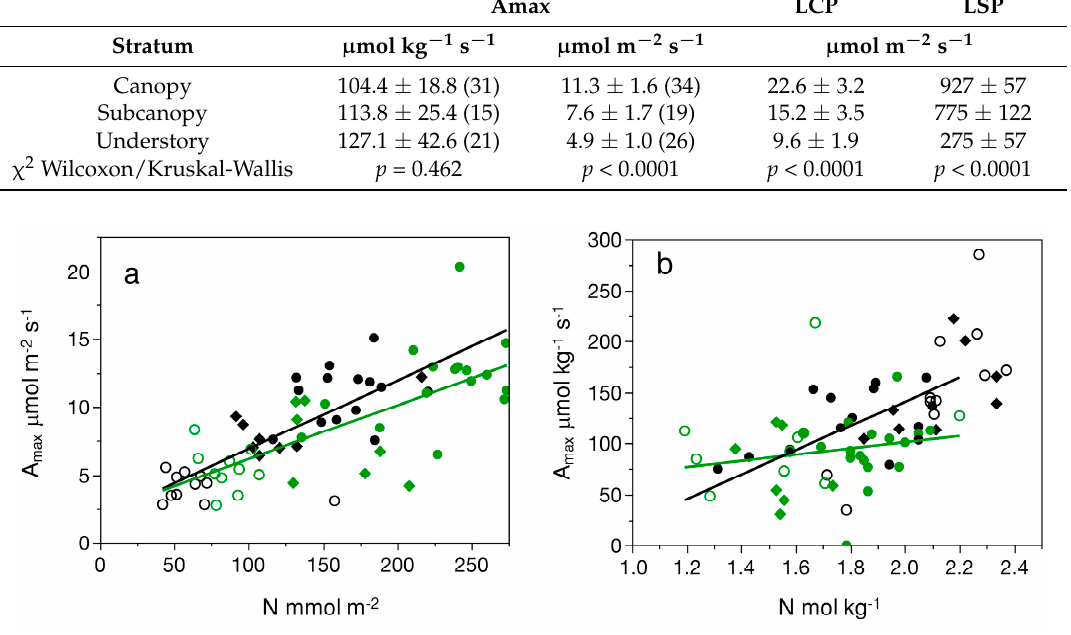
Figure 5. Relationship between A max and N concentration per unit area (A max area , ( a )), and unit mass (A max mass , ( b )). Symbols as in Figure 3. For C. elastica , A max area = 1.87 + 0.05 N area , R 2 adj = 0.59, F = 47, p > F < 0.0001, n = 33; A max mass = − 97.9 + 119.4 N mass , R 2 adj = 0.38, F = 21, p > F < 0.0001. For the group of native species, A max area = 2.18 + 0.04 N area , R 2 adj = 0.50, F = 31, p > F < 0.0001, n = 33; R 2 adj = 0.005, not significant.